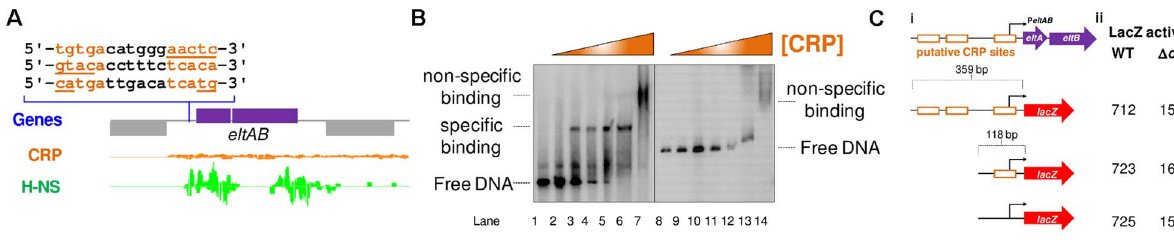
Fig. 6. The eltAB promoter is indirectly repressed by CRP. A) The Panel shows ChIP-seq data for CRP and H-NS binding at the eltAB locus. The sequence of 3 putative CRP binding sites proposed by Bodero and Munson (2009) are shown. The CRP and H-NS binding profiles are plots of sequence read counts at each position of the genome on both the top (above the central line) and bottom (below the central line) strand of the DNA. The y-axis scale for H-NS binding is 1,785 reads on each strand and for CRP binding is 14,000 reads on each strand. B) Results of an Electorphoretic Mobility Shift Assay to measure binding of CRP to the 93 bp P estA2 fragment (Lanes 1–7) or the 359 bp P eltAB fragment (Lanes 8–14). Specific and non-specific binding of CRP is indicated to the left and right of the gel. CRP was added at a concentration of 0.2–7.0 m M. C) Panel (i) shows different P eltAB::lacZ fusions. The lacZ gene is shown as a red arrow and the eltAB operon is shown in purple. P eltAB is illustrated using a bent arrow and the putative CRP binding sites are shown as open orange boxes. In panel (ii) the values are b -galactsidase activity measurements taken in M182 or the